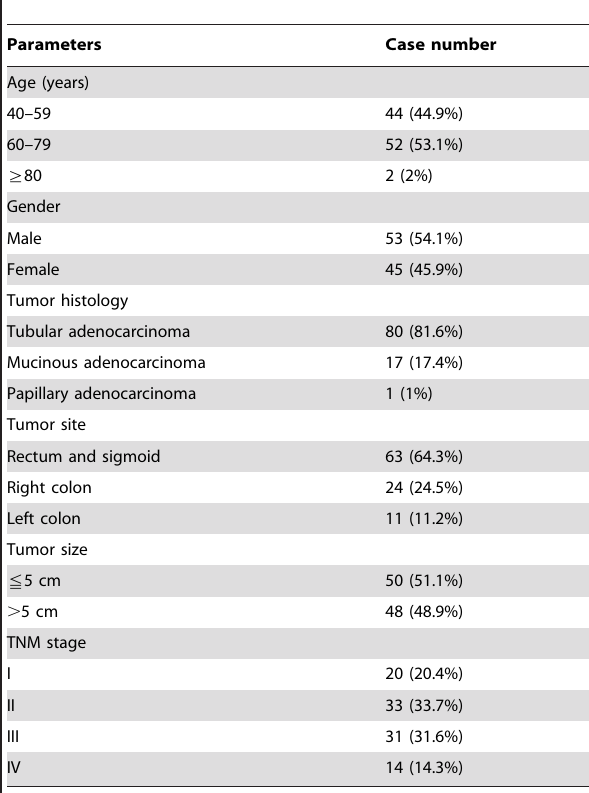
Table 1. Demographic and clinicopathological data.